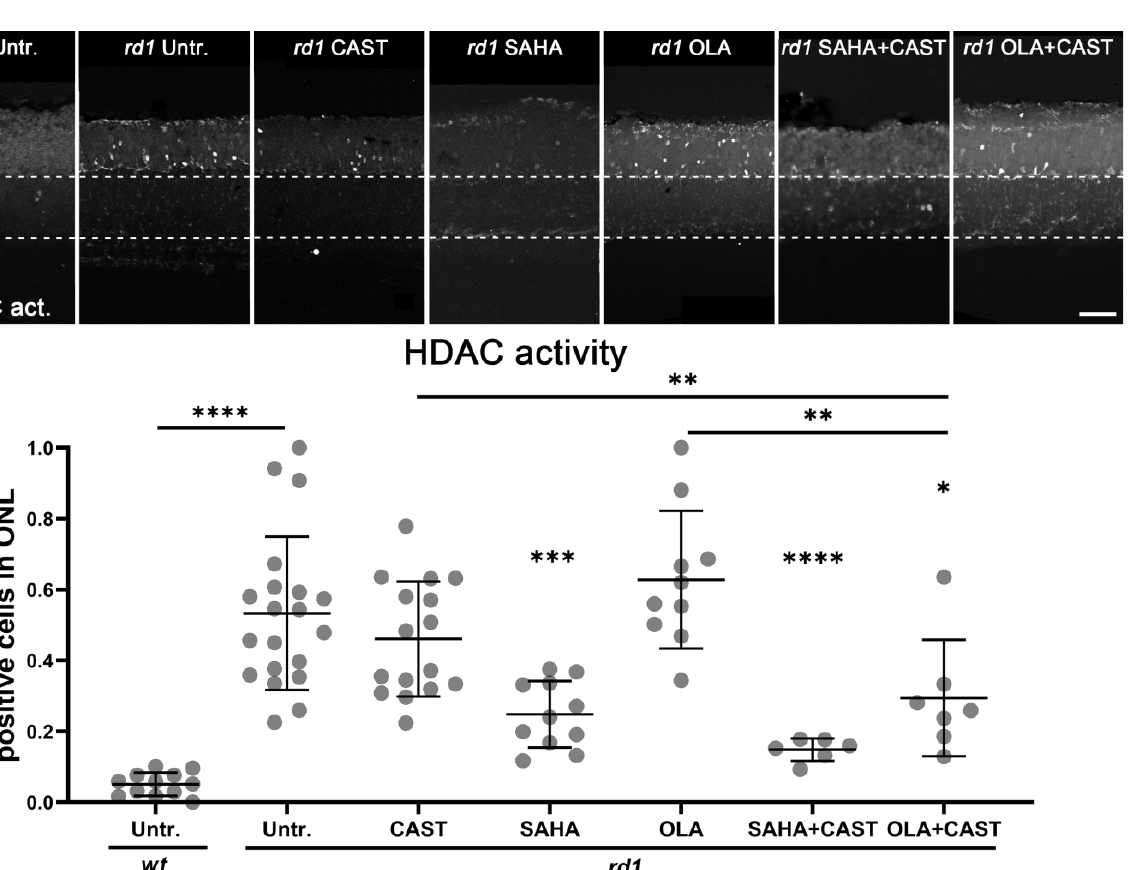
layer (ONL) of treated or untreated (Untr.) retina. Note the strong increase in calpain activity in the rd1 ONL when compared to wt . Both mono- and combination therapies significantly reduced rd1 calpain activity. However, combination therapy did not produce additional benefits over monotherapy. ( C ) Immunostaining specific for activated calpain-2 (yellow). DAPI (grey) was used for nuclear counterstaining. ( D ) Quantification of activated calpain-2 positive cells in the ONL. Calpain-2 activation was markedly increased in the rd1 ONL and significantly decreased by the various drug treatments. Images shown represent at least five different specimens for each genotype. For calpain